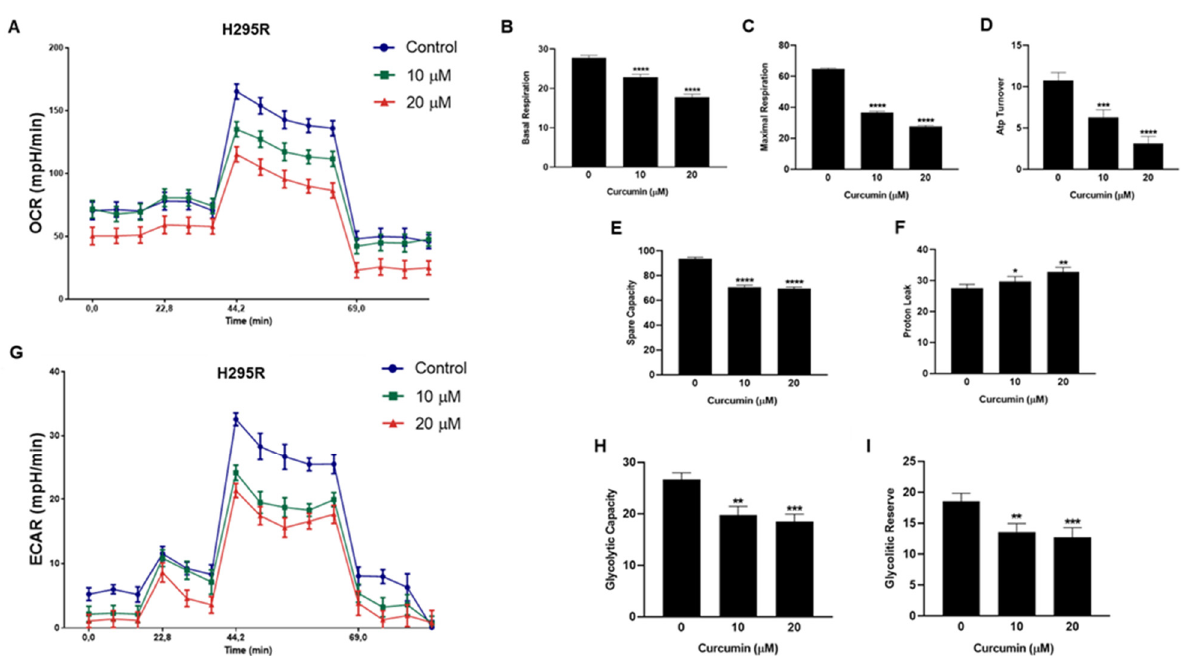
Figure 4. Curcumin affects H295R cell metabolism. ( A ) Real-time oxygen consumption rate (OCR) from H295R cells treated with curcumin (10 and 20 µ M) for 16h assessed by Seahorse XF96 analyzer. ( B – F ) Bar chart showing mitochondria functional parameters: ( B ) Basal respiration; ( C ) Maximal respiration; ( D ) ATP turnover; ( E ) Spare capacity; ( F ) Proton leak. ( G ) Real-time extracellular acidification (ECAR) rates from H295R cells treated with curcumin (10 and 20 µ M) for 16h. Bar chart showing Glycolytic capacity ( H ) and Glycolytic reserve ( I ). * p < 0.05; ** p < 0.01; *** p < 0.001; **** p < 0.0001 vs. 0 μ M.